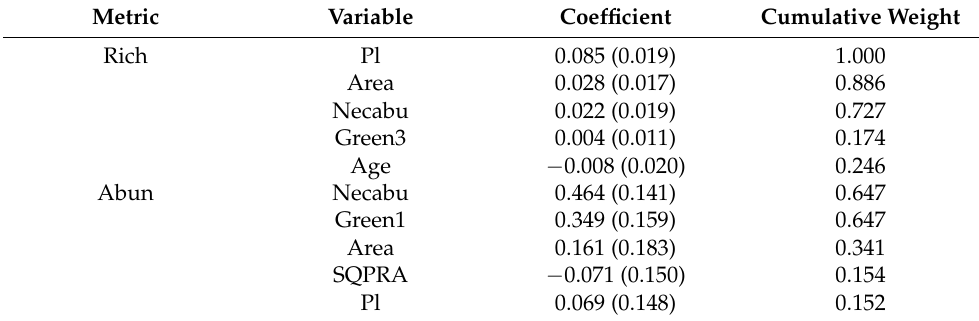
Table 5. Model-average coefficients ( ± SE) for all variables included in the best-ranked models (i.e., those with ∆ AICc <2) and cumulative model weights (Rich: butterfly species richness; Abun: butterfly abundance). The explanatory variables presented in the best models are plant species richness (Pl), park area (Area), flowering abundance of nectar plants (Necabu), park completion time (Age), perimeter/area ratio of each park (SQPRA), the proportion of green space cover within 50 m of the park boundary (Green1) and the PCA axis explaining the highest variation in the proportion of green space cover within 1000 m, 2000 m and 3000 m from the park boundary (Green3). Metric Variable Coefficient Cumulative Weight Rich Pl 0.085 (0.019)